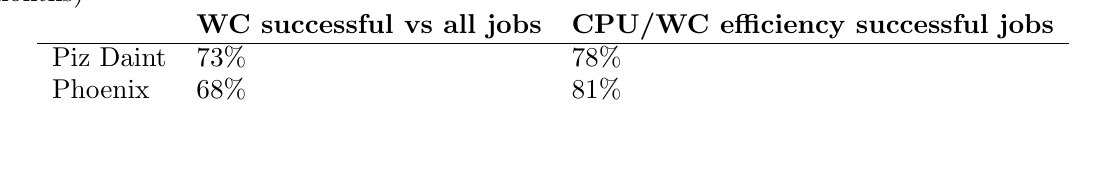
between ATLAS, CMS and LHCb according to the target shares, continuity of allocation for ATLAS and capability of filling the allocated